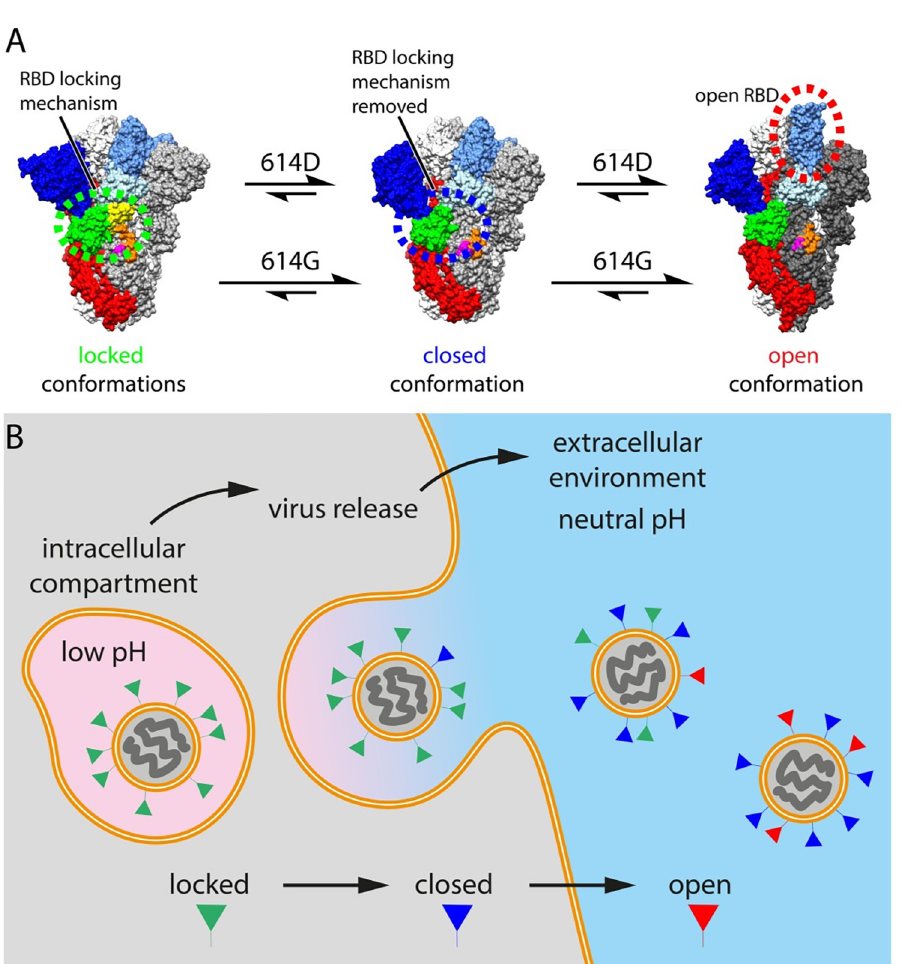
Fig 5. SARS-CoV-2 virus particle release and the accompanied structural transitions of surface spike protein. (A) the three prefusion conformational states observed for the SARS-CoV-2 spike protein and factors that influence the structural transitions between the conformational states. Data in this study suggests that the D614G mutation may modulate locked to closed transitions. Data in the literature suggests that the D614G mutation may also modulate closed to open transitions and the stability of the open form (see main text). (B) schematic diagram illustrating the release of nascent SARS-CoV-2 virus particles from the cell. Green, blue or red triangles indicate the predicted conformational states of spike proteins as the virus travel through the acidic (pink) intracellular compartment before it was released into the neutral (blue) extracellular environment.